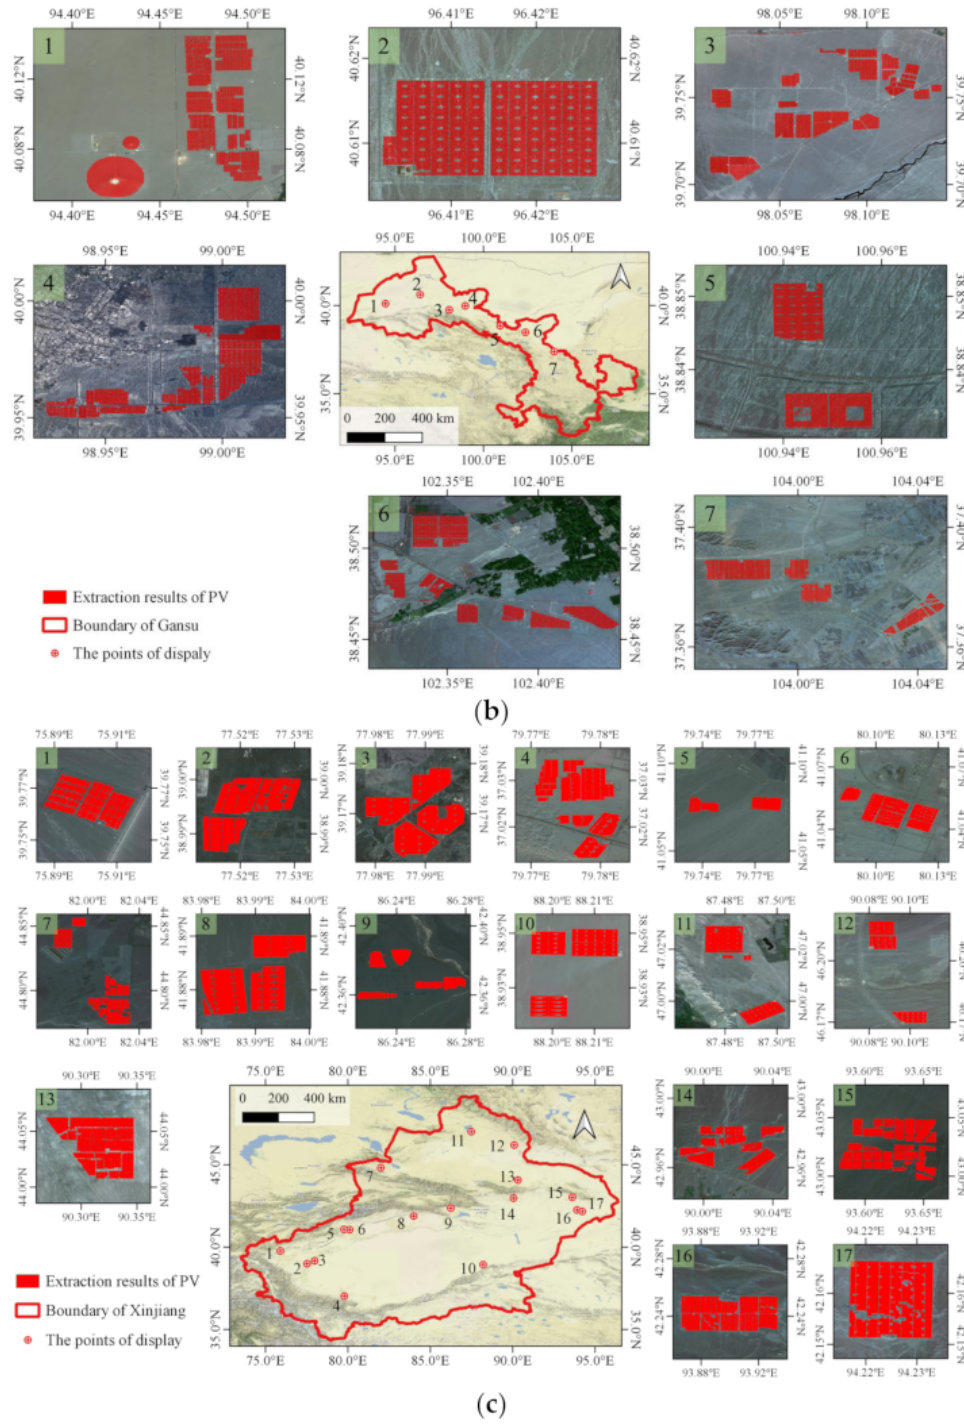
Figure 10. Precise extraction results in the study area. ( a ) Precise extraction results of the photovoltaic panels in Qinghai Province. ( b ) Precise extraction results of the photovoltaic panels in Gansu Province. ( c ) Precise extraction results of the photovoltaic panels in Xinjiang Uygur Autonomous Region. Three main classes that are easily misclassified as scenes containing photovoltaic panels are shown in Figure 11. The first row of images are scenes that were mistaken for containing photovoltaic panels in the 16-m spatial resolution remote sensing image; the second row of images are the 2-m spatial resolution remote sensing images corresponding to the first row of images; the third row of images are extraction